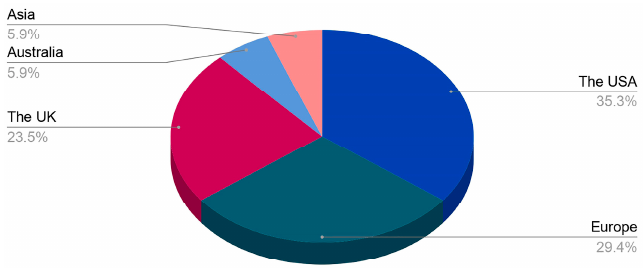
Figure 3. Country Distribution of the Literature.